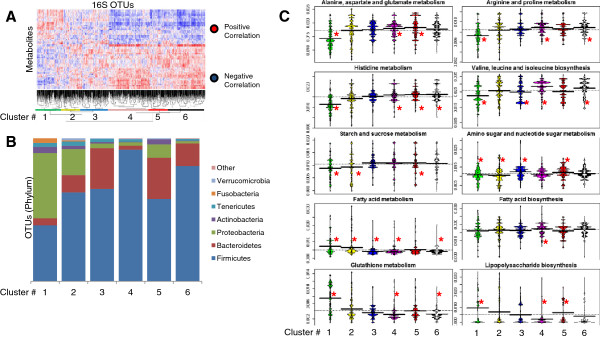
Cecal microbial clusters. Heat maps were created that were sorted based on hierarchical clustering of both bacteria and metabolites (A). The microbial dendrograms were then cut such that six or seven microbial clusters were generated based on k-means prediction strength. The number and horizontal span of each cluster is indicated at the bottom of the dendrogram. The proportion of the phylotypic clades comprising each cluster is depicted for each cluster (B). To determine the differences in imputed metagenomic enrichments/depletions of Kyoto Encyclopedia of Genes and Genomes (KEGG) pathways between clusters, the metagenomic composition of each operational taxonomic unit (OTU) was then computed using phylotypic investigation of communities by reconstruction of unobserved states (PICRUSt) and quantitatively analyzed for relative genomic pathway abundance using Unified Metabolic Analysis Network (HUMAnN) and Kruskal-Wallis one-way analysis of variance. Only pathways that significantly varied in at least one cluster (Bonferroni, P <0.05) are shown (C). Beanplot colors differentiate cluster numbers; *Bonferroni, P <0.05.